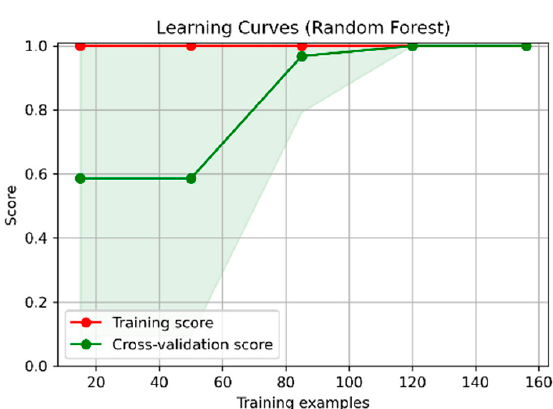
Figure 7. Learning curve for the random forest model for data from 2021.